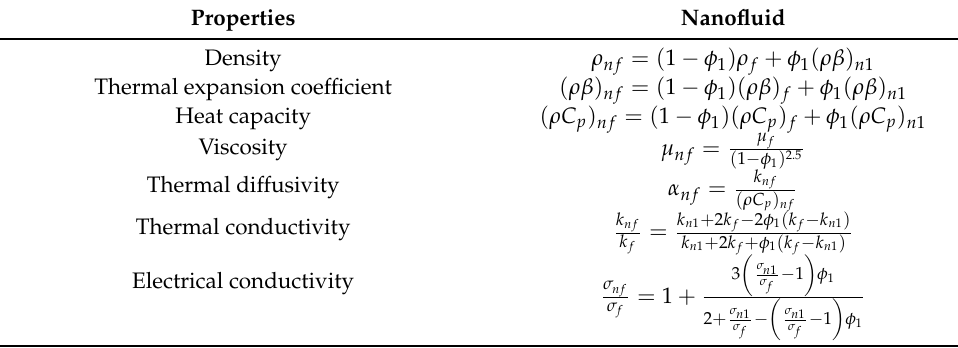
Table 2. Thermophysical properties of nanofluid (type I) [34].